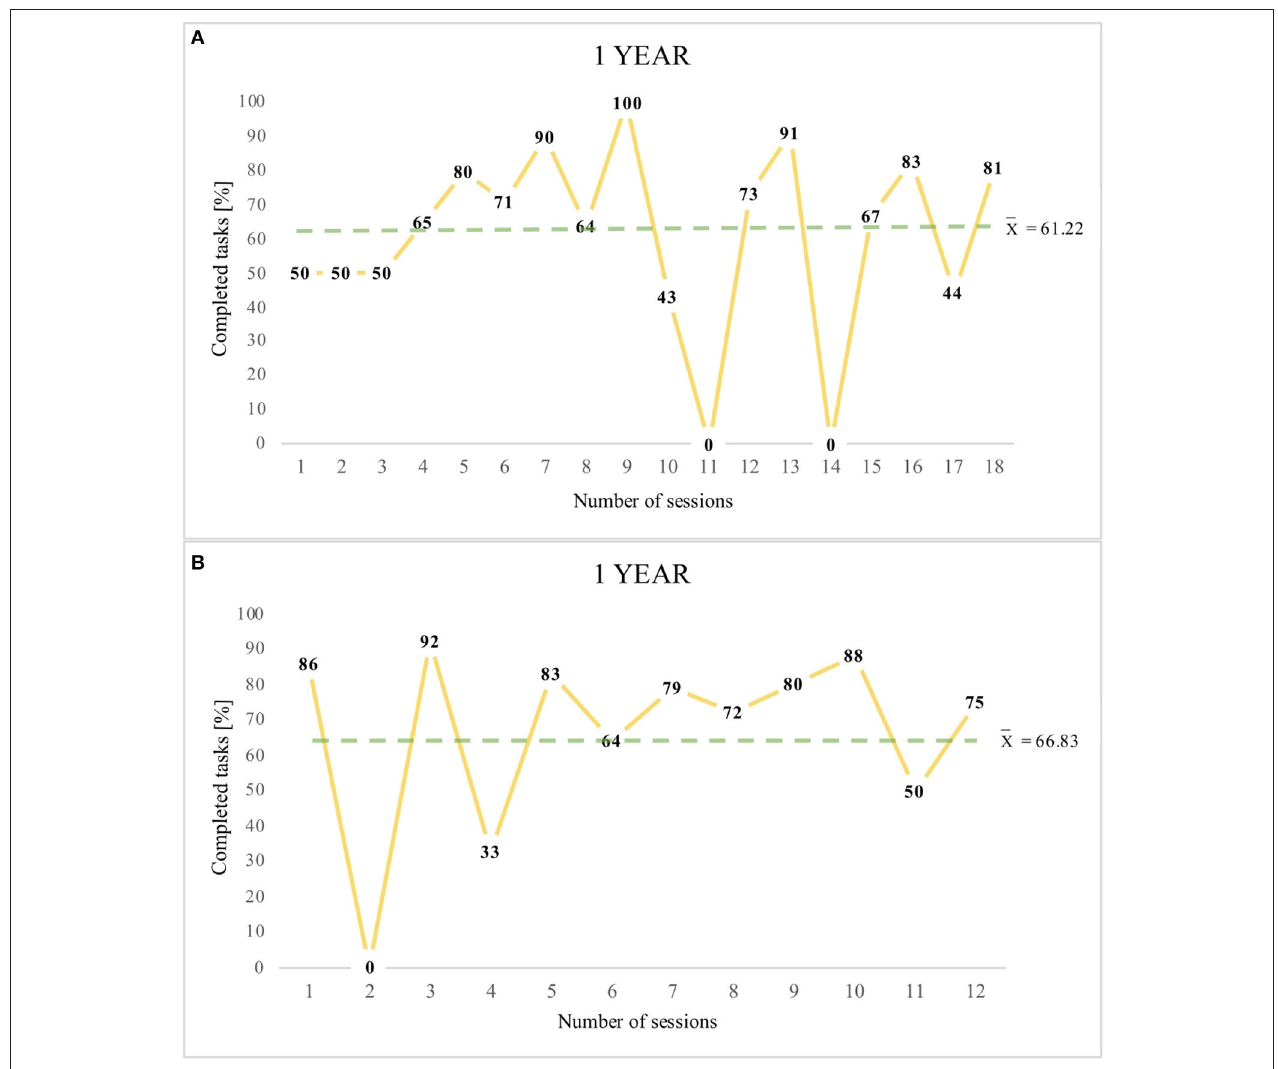
FIGURE 4 | Patient 5- graph (A) and Patient 6- graph (B) (1 year of work with the